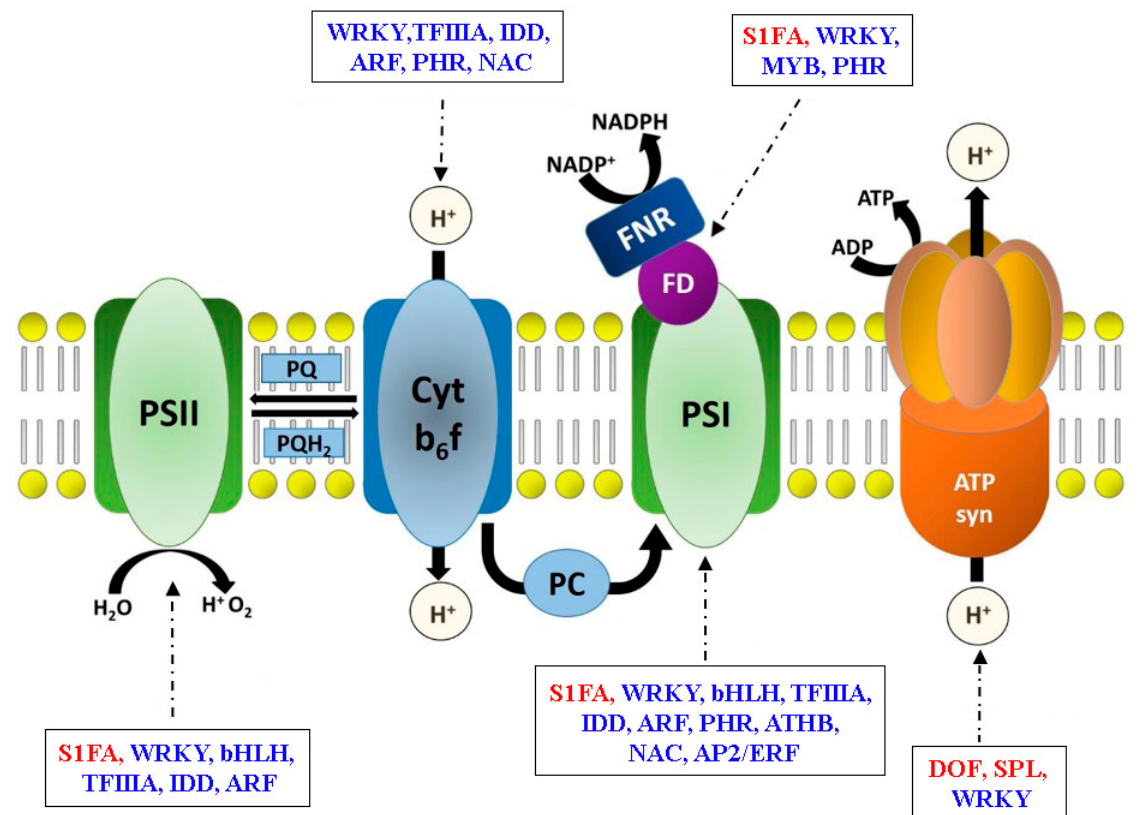
Figure 7. Schematic model of genes participating in the photosynthesis pathway (ko00195). The TFs were identified by the gene co-expression network. Arrows represent the regulatory relationship between transcription factors and genes encoding subunit enzymes involved in plant photosynthesis. Red and blue colors within boxes identify positive and negative regulation, respectively.